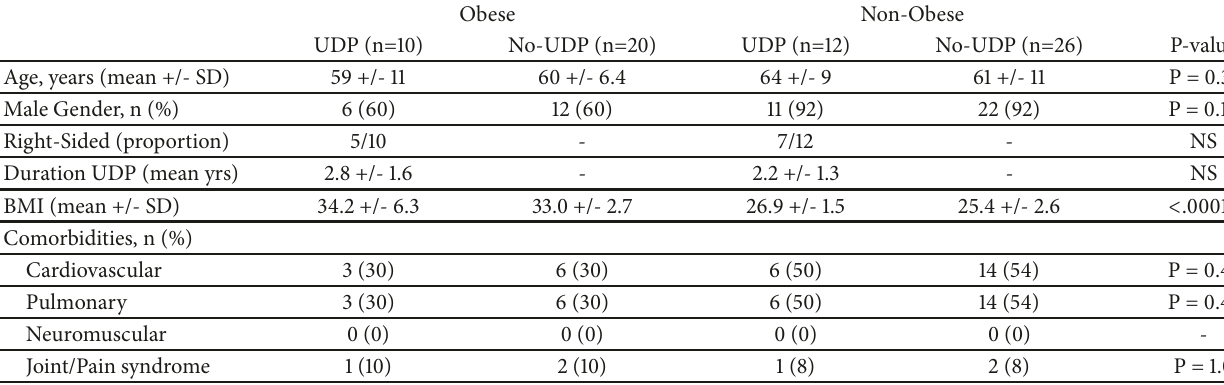
Table 1: Demographic matching of UDP to non-UDP